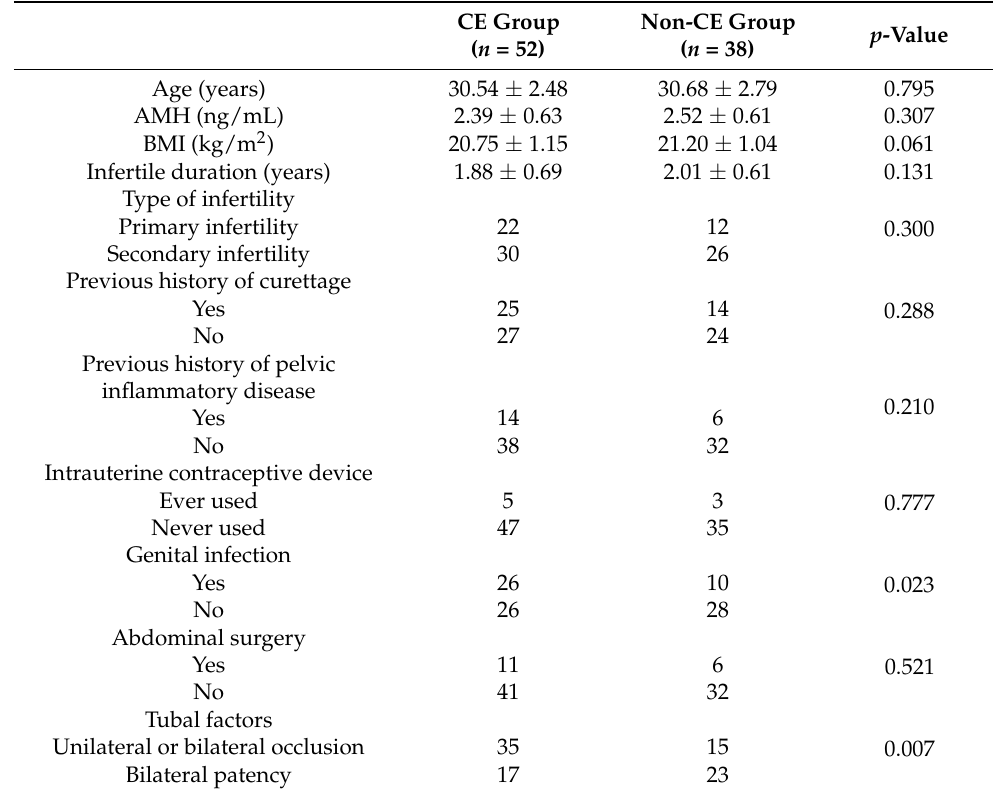
Table 1. Comparison of general information and risk factors between CE and non-CE